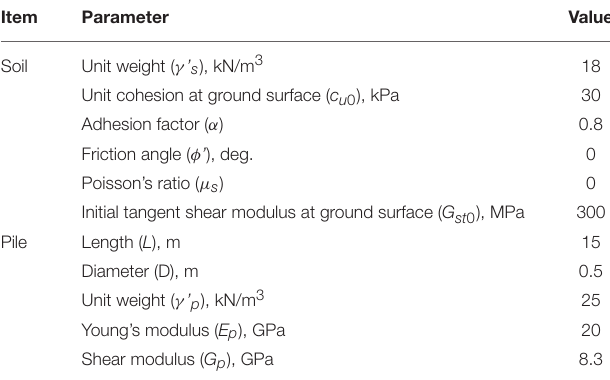
TABLE 1 | Input parameters of soil and pile for the parametric